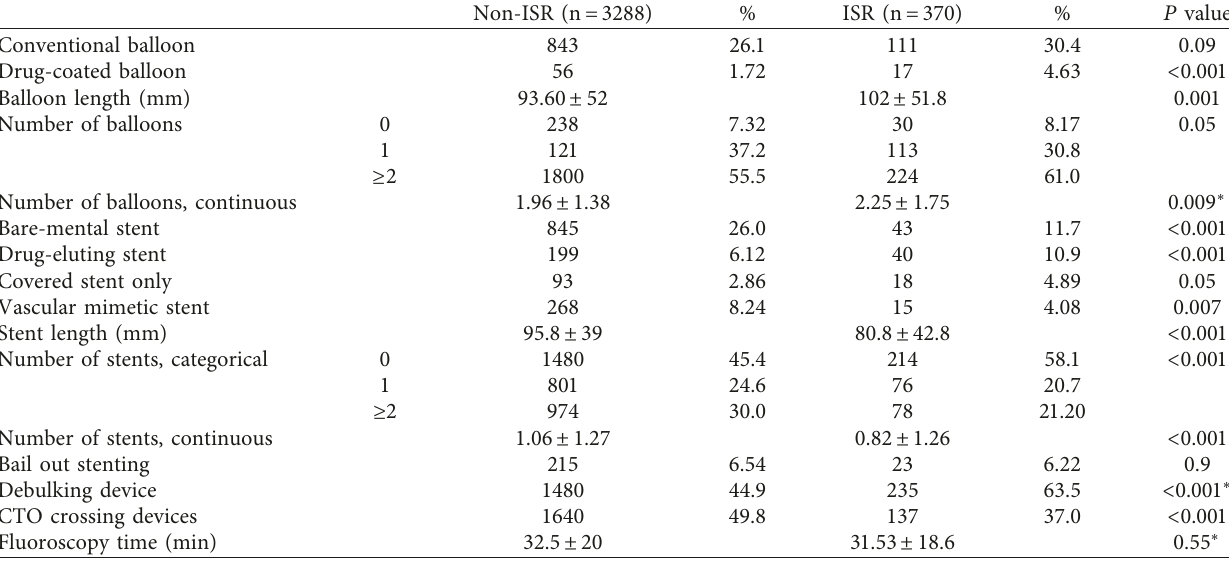
Table 3: Endovascular treatment strategy for femoropopliteal (FP) non-in-stent restenosis and in-stent restenosis (ISR) groups.